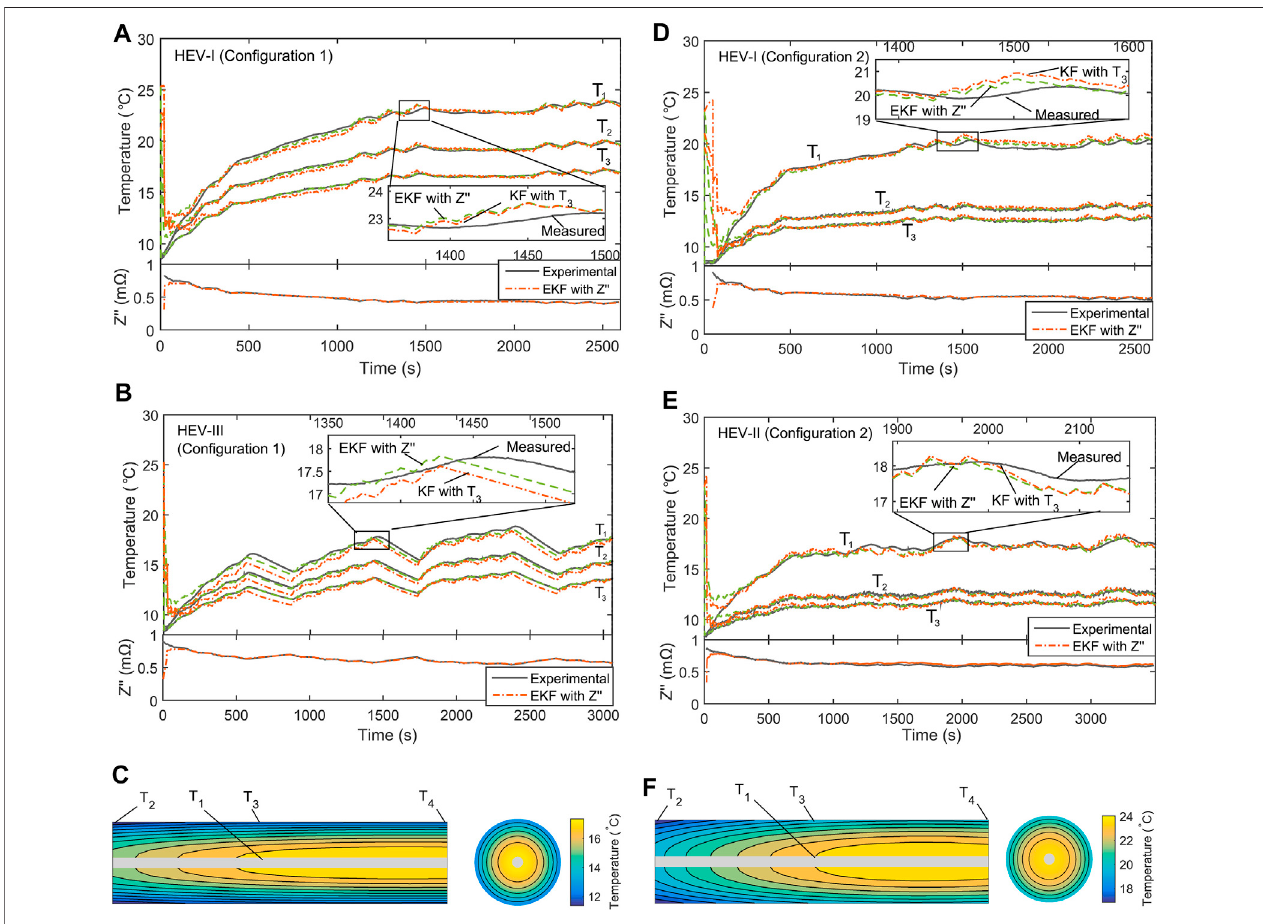
FIGURE10| Estimationresults ofEKF with impedance and KFwithsurface temperature measurement. (A) HEV-Itest with cooling (B) HEV-III test withcooling (C) temperature distribution modeled at the end of the HEV-I cycle (D) HEV-I test with no cooling (E) HEV-II test with no cooling (F) temperature distribution modeled at the end of the HEV-II cycle (Richardson et al., 2016a; Panel 7, p.733). (CC BY-NC-ND